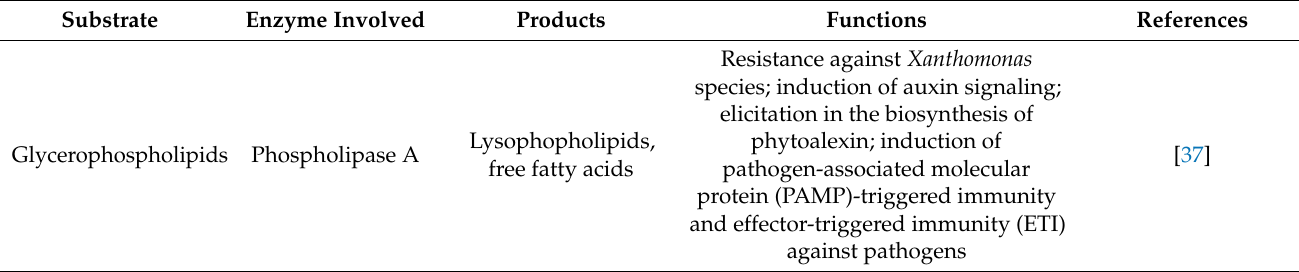
Table 1. Involvement of membranous lipids and their associated enzymes during plant–pathogen interaction.